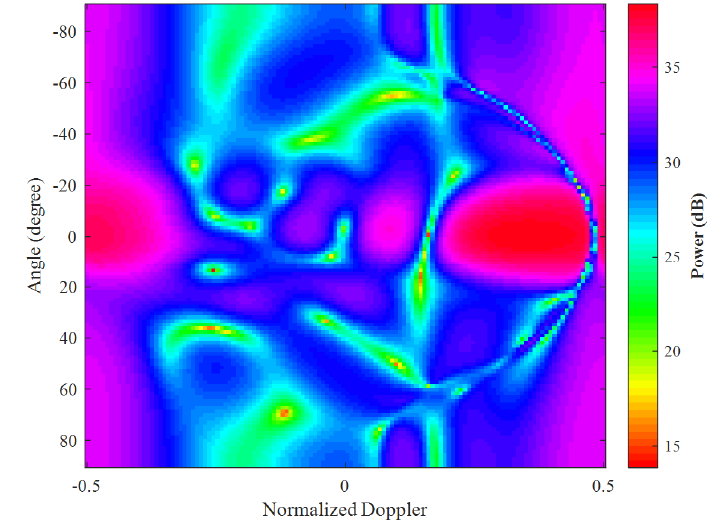
Figure 14. Angle–Doppler projection of 3D processed data.